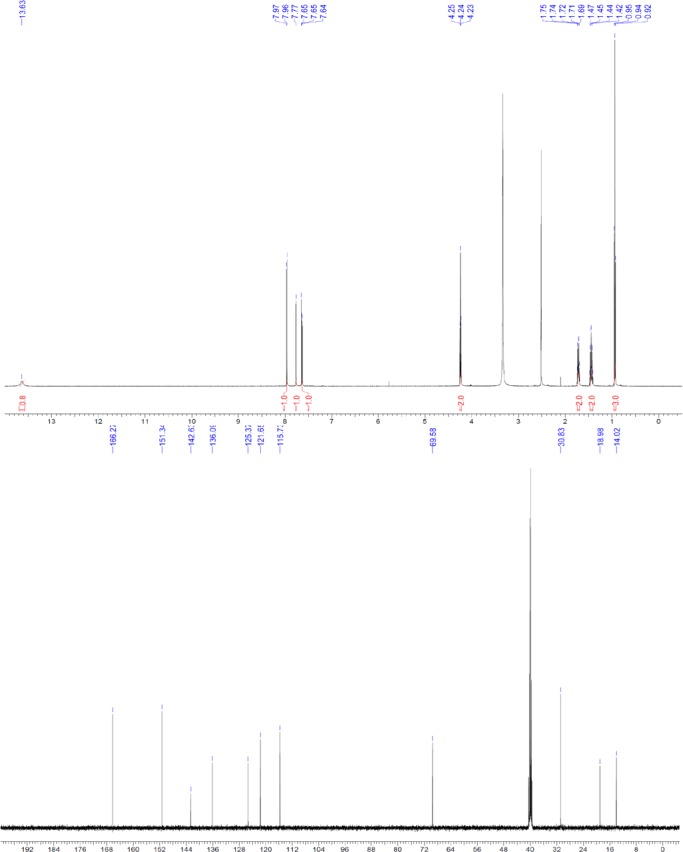
1H and 13C NMR of compound 3c.